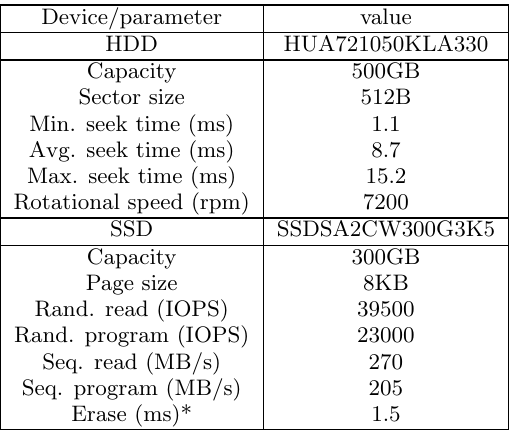
Table 4: The devices characteristics * unknown, we consider the mean actual value for